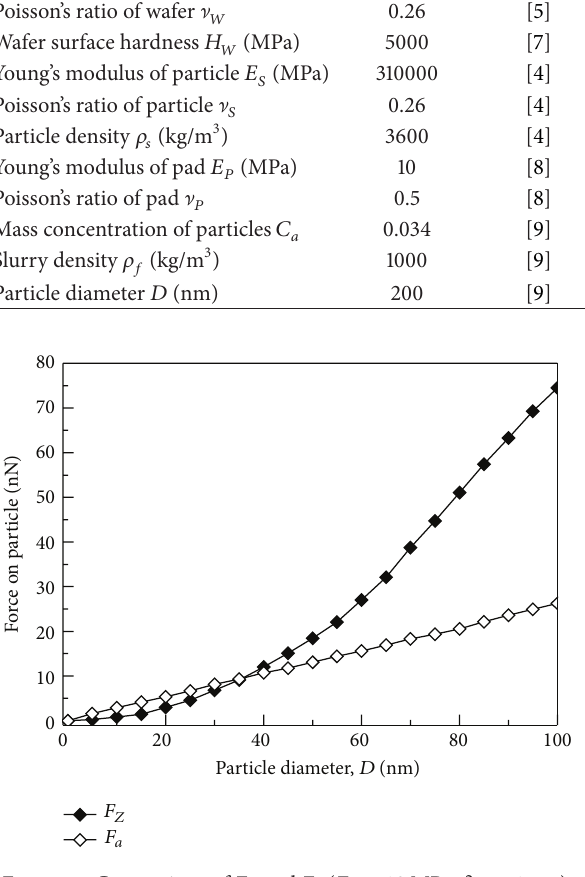
and the molecular adhesion force between particle and wafer 𝐹 𝑎 , an example is used by theoretical calculation to compare 𝐹 𝐹 𝑍 and 𝑎 that assumes an Al 2 O 3 abrasive is pressed into the surface of Cu wafer. The Hamaker constant of Cu-Water- Al 2 O 3 system is calculated as 9 × 10 −20 J by (13), the inden- tation depth 𝛿 𝑊 is taken as 1 nm, and other parameters are listed in Table